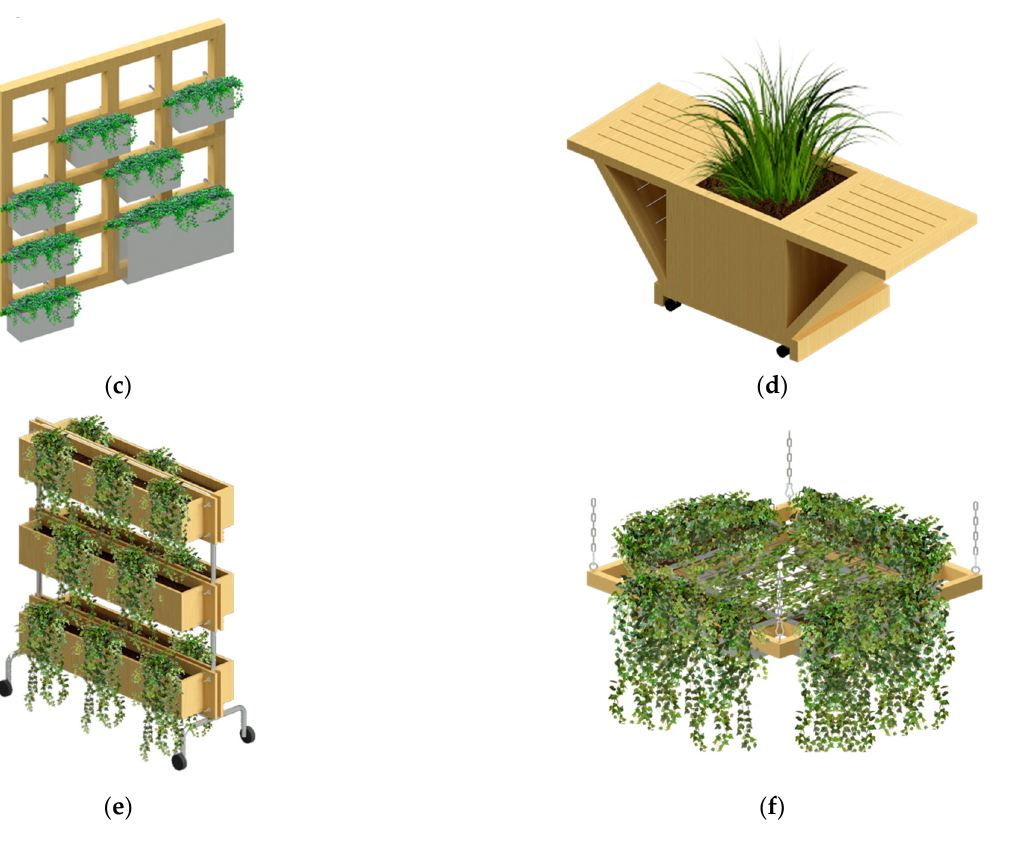
Figure 1. First drafts of the facade and interior greening systems of the participating students of the Camillo Sitte Bautechnikum in Vienna: ( a ) facade greening system “The Green Plug” made of clinker bricks; ( b ) facade trough made of clinker bricks; ( c ) modular wall greening system; ( d ) plantable seating furniture “Green Domino”; ( e ) plantable mobile partition wall; ( f ) greened hanging system “Green Cloud”.